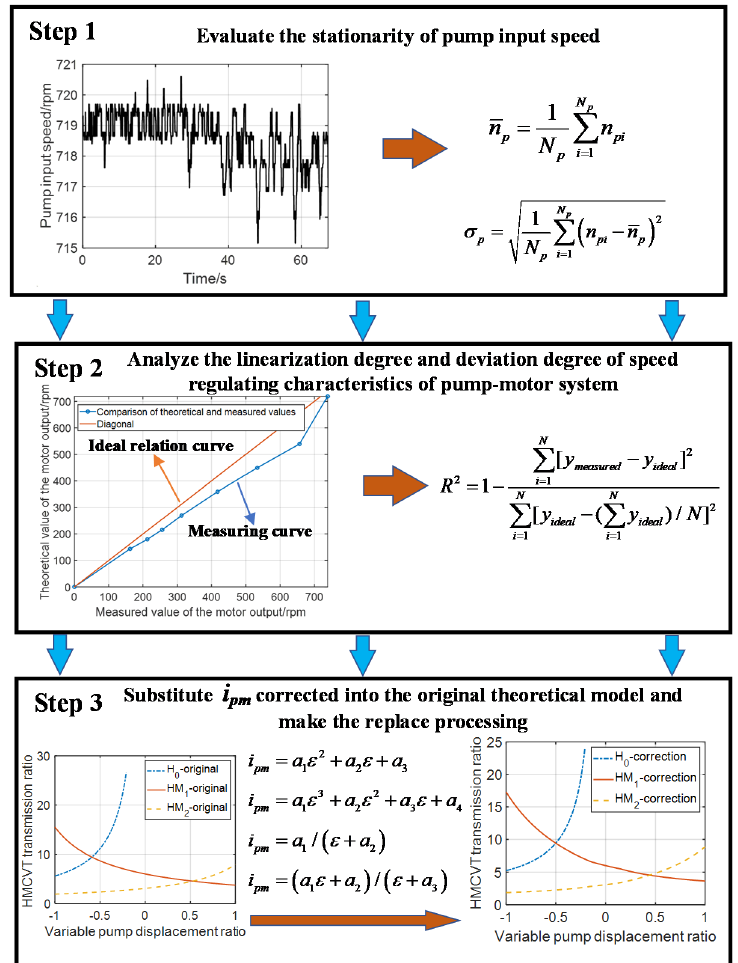
Figure 3. The technical route of correction method proposed for speed regulating characteristics.